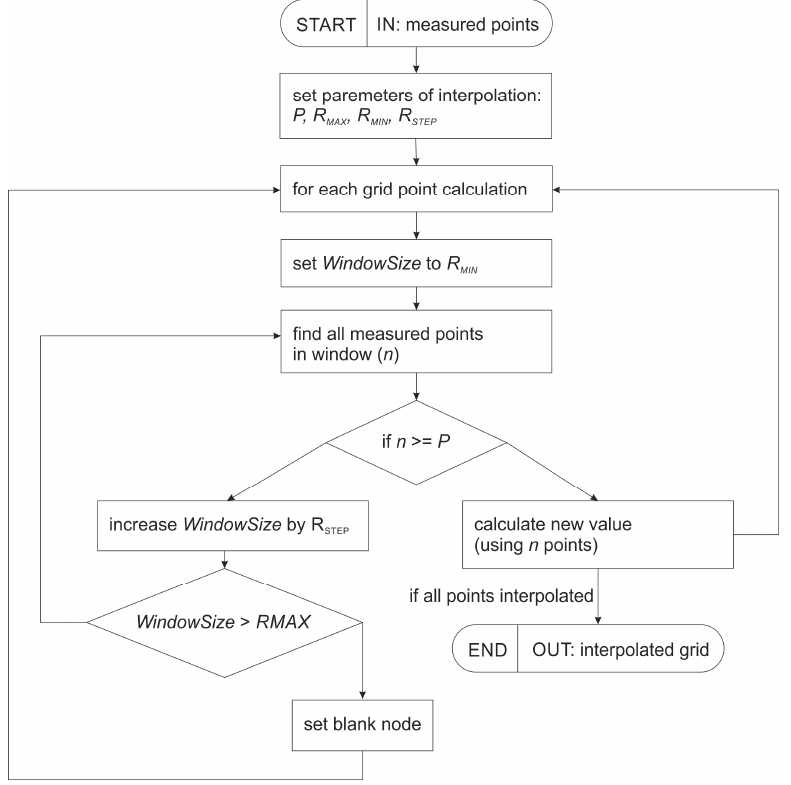
Figure 10. Simplified scheme of optimization of the Kriging method using ‘growing radius’.